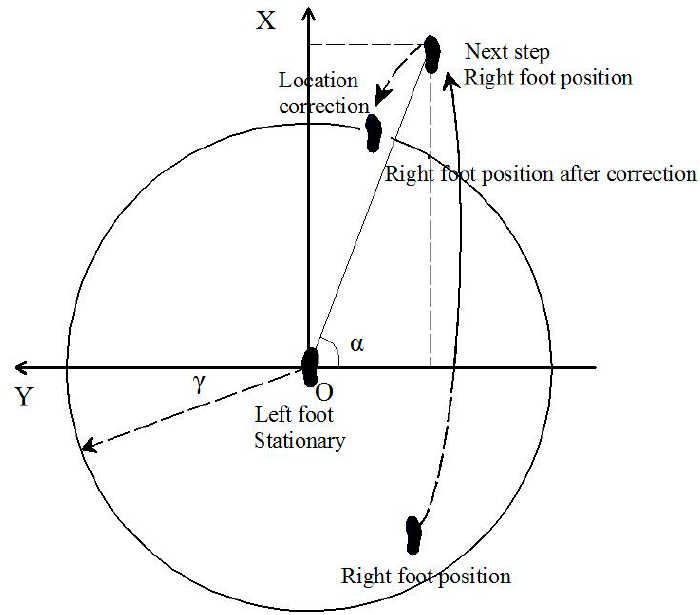
Figure 3. Level constraint for one foot: a circle of radius γ , centered at the other foot.